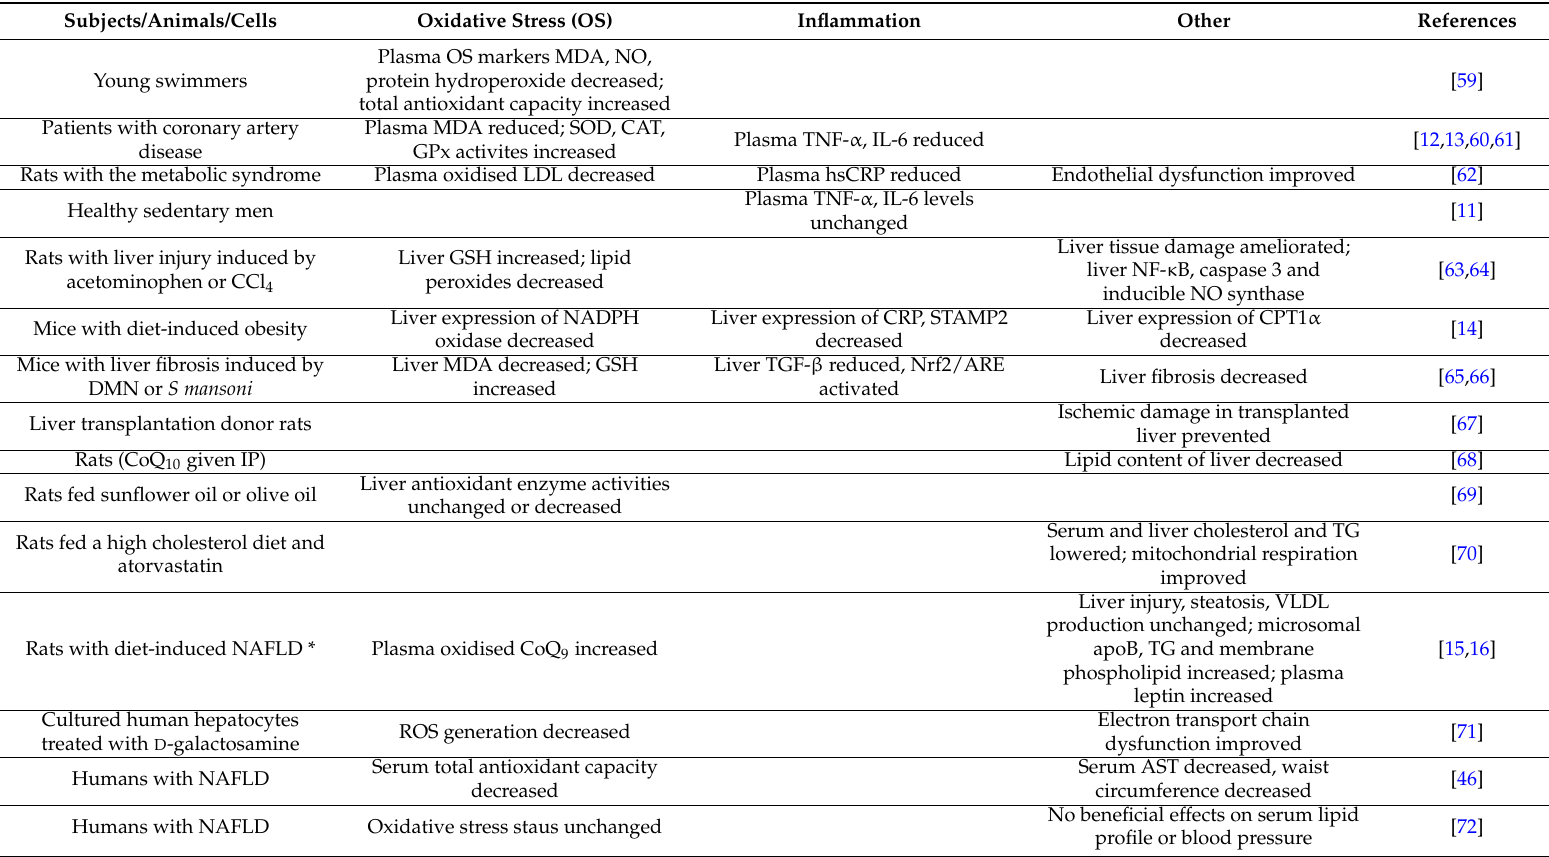
Table 1. Summary of studies on the effects of dietary CoQ supplementation on NAFLD and related